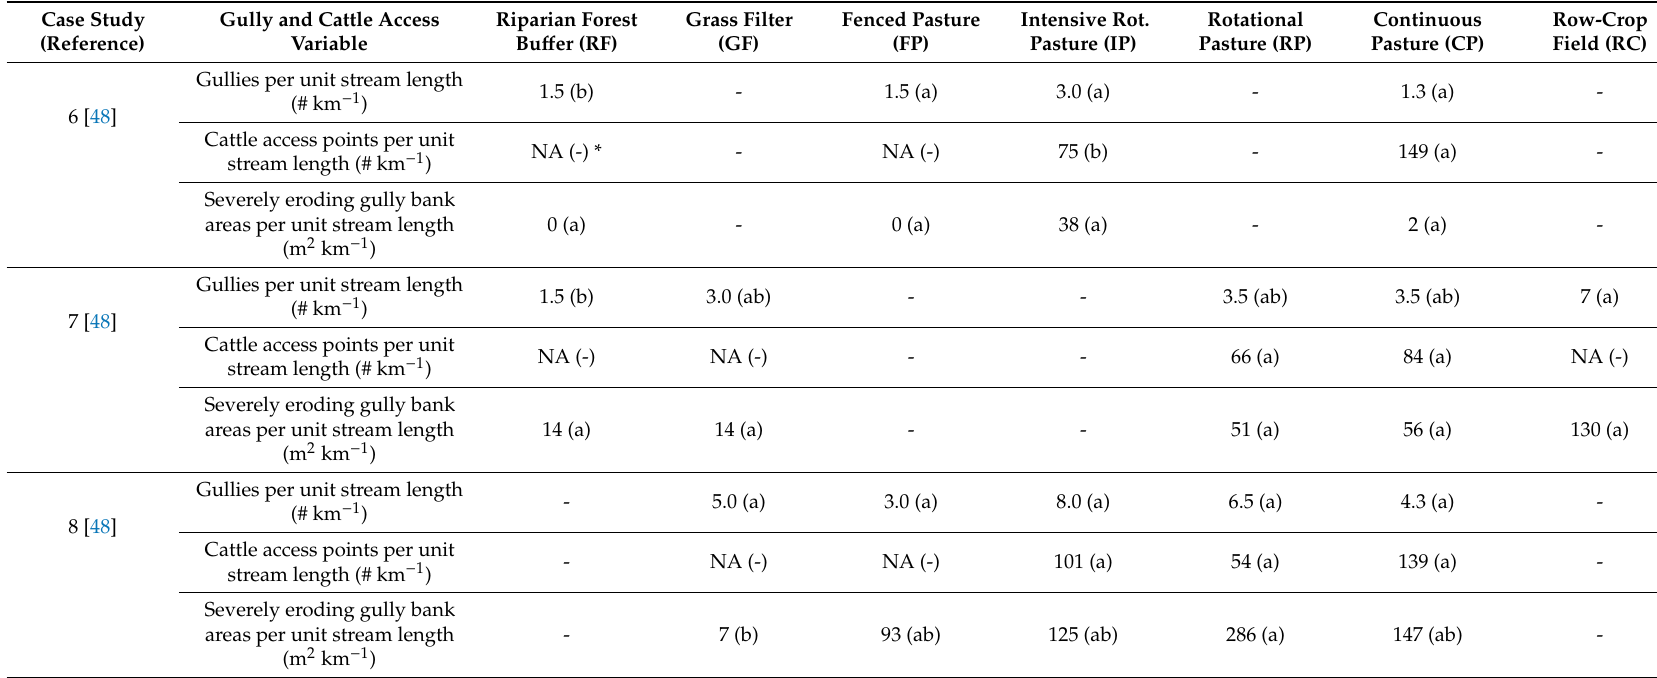
Table 5. The number of gullies (both classic and ephemeral) and cattle access points and the severely eroding gully bank areas per stream length in the NE, CE, and SE region studies. Significant di ff erences among riparian land-uses within a region are indicated with a di ff erent letter in parenthesis ( p <